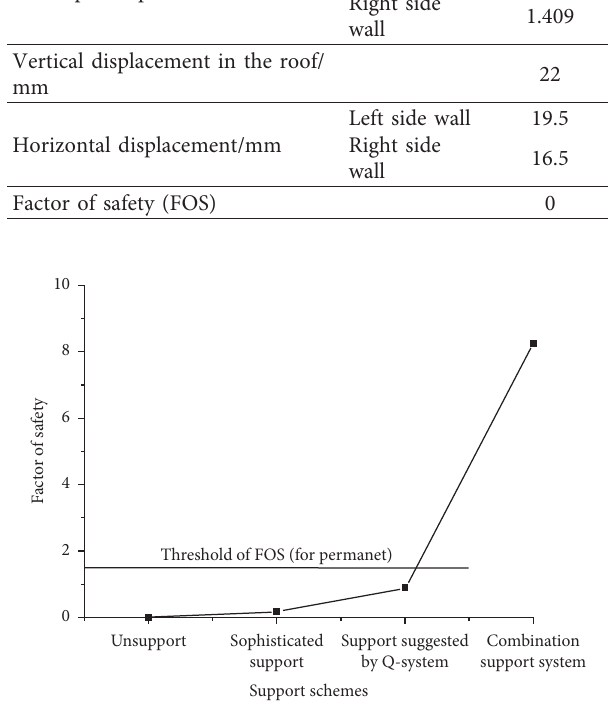
Figure 13: FOS surrounding the weak rock drift obtained from 3 different support designs.